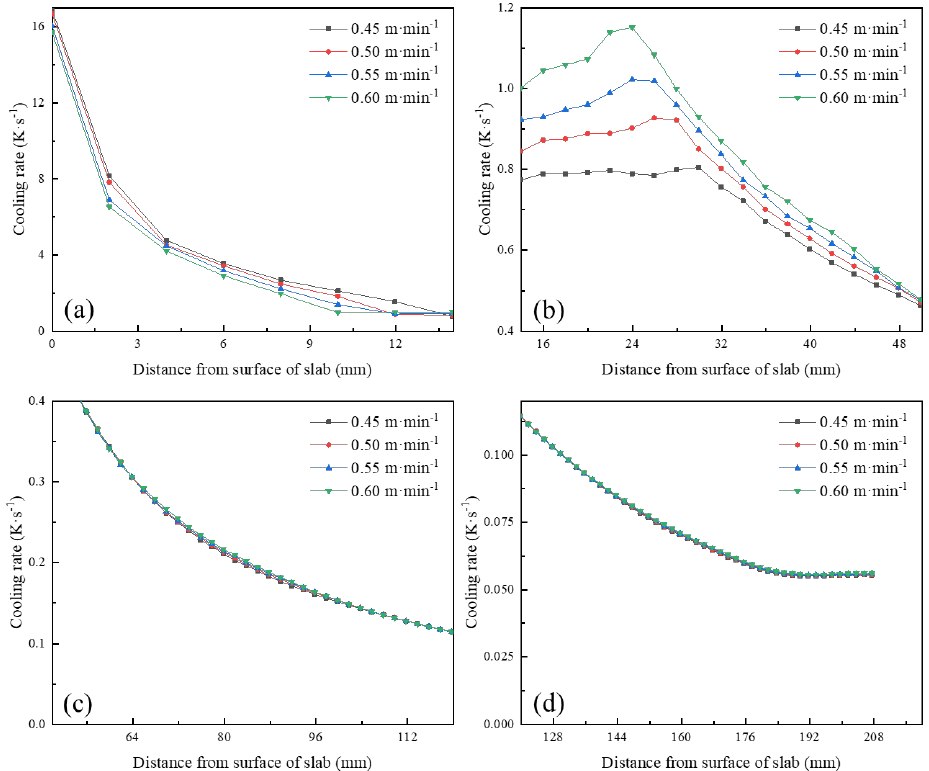
Figure 7. Cooling rate at different positions from surface of slab under different casting speeds: ( a )